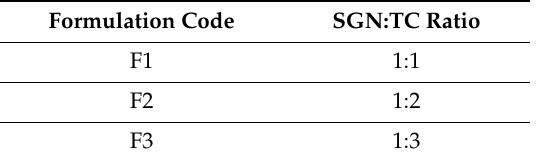
Table 5. The compositions of SGN–TC nanoparticles based on di ff erent drug polymer ratios. Formulation